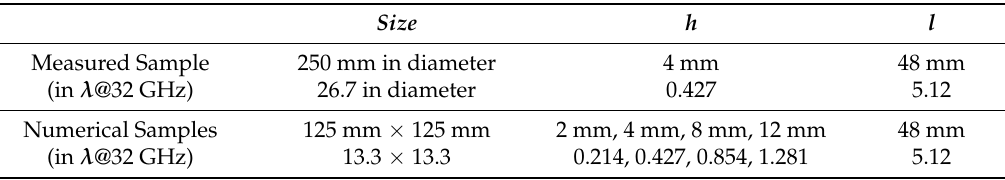
Table 1. Parameters of the exponentially correlated rough surface samples.